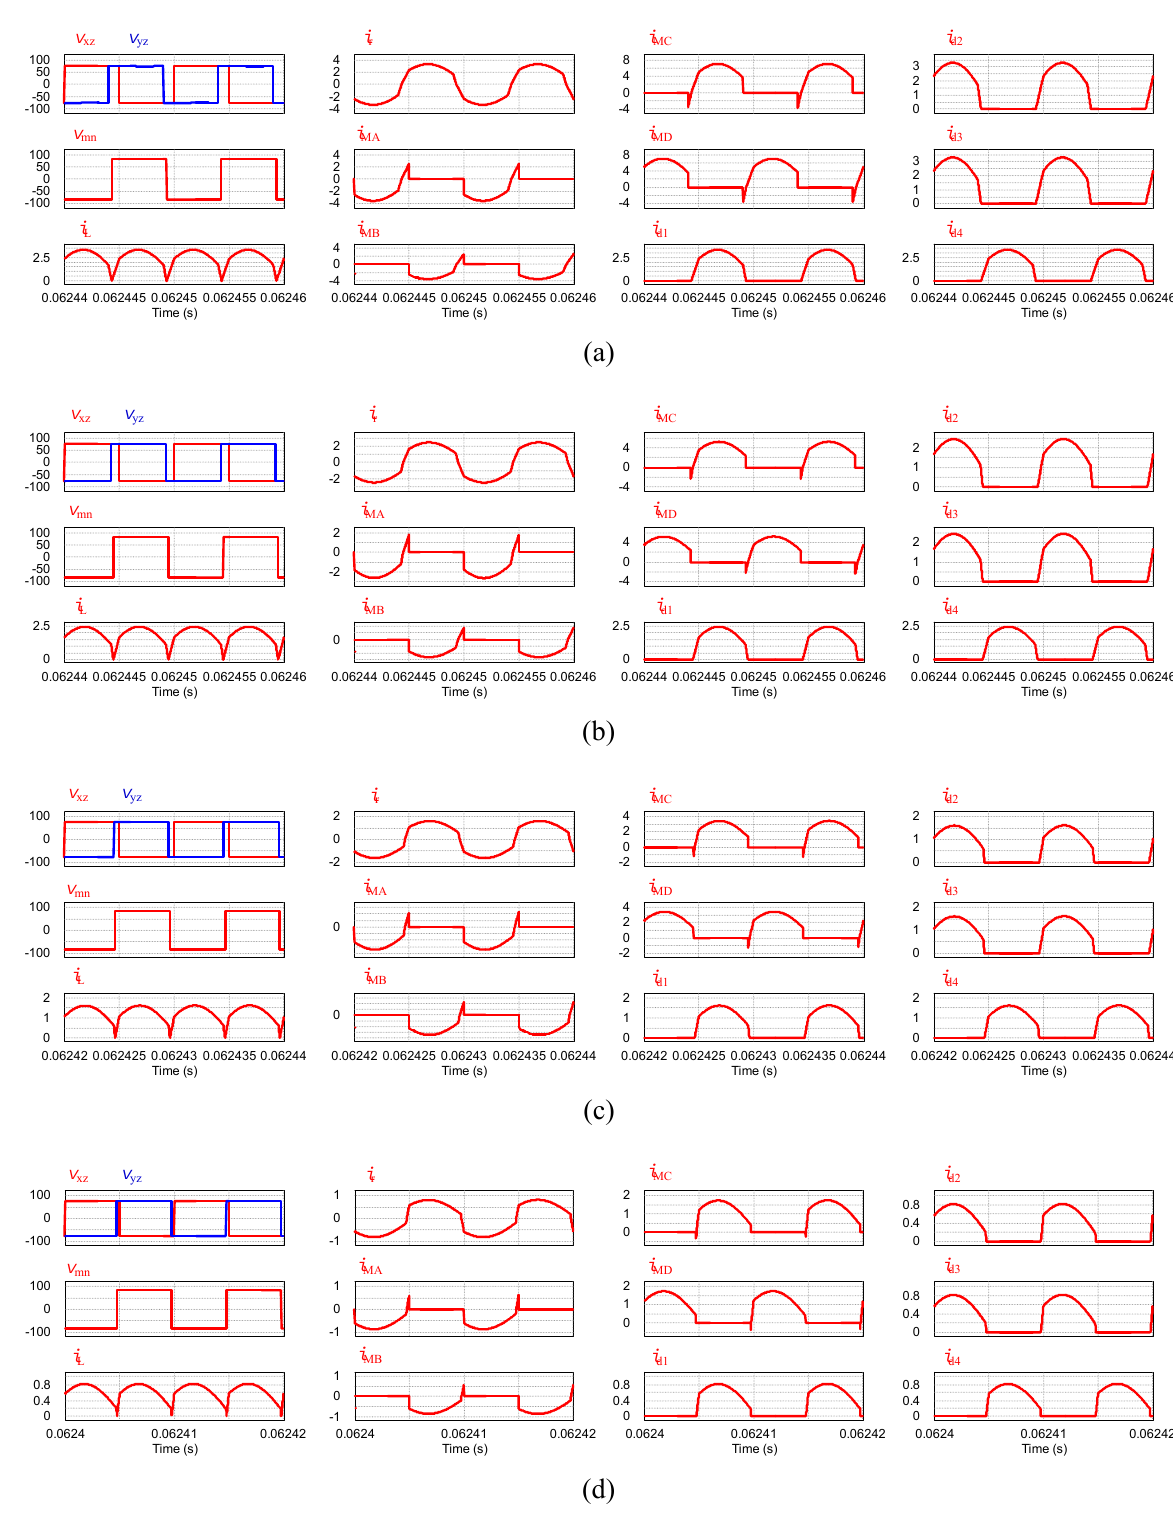
Figure 10. The key simulation waveforms of the DTRC at k = 0.5 when M = 0.5: ( a ) 200 W; ( b ) 150 W; ( c ) 100 W; and ( d ) 50